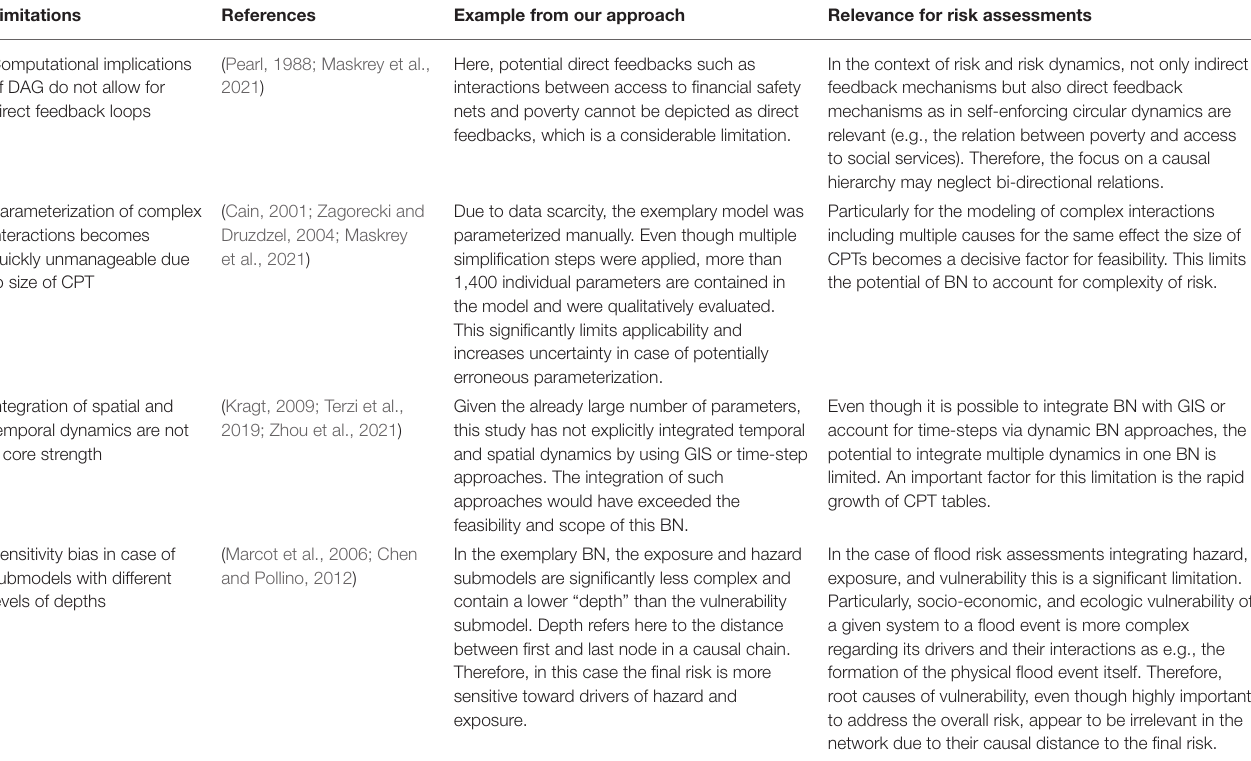
TABLE 3 | Limitations of Bayesian